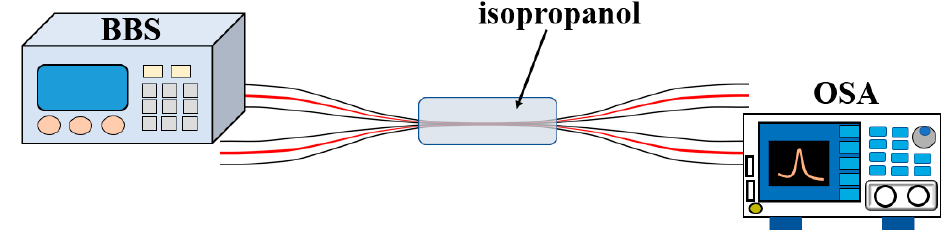
Figure 3. Experimental setup diagram of MCF temperature sensor under broadband light source.